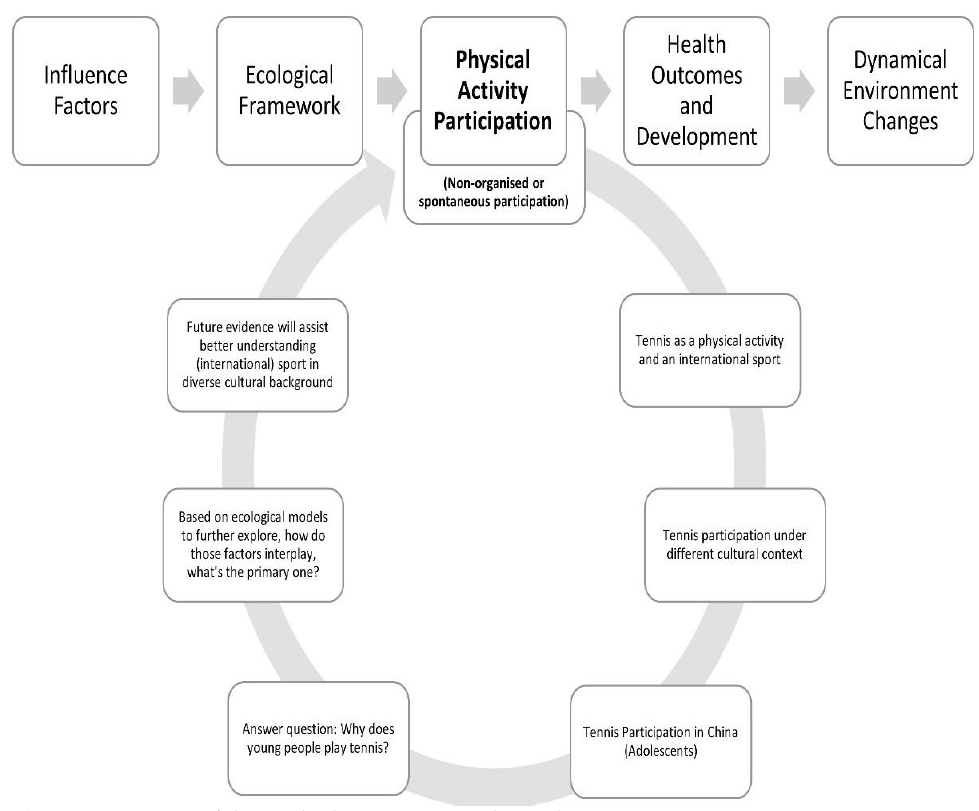
Figure 1. Diagram of the study design, aims, and initial questions.